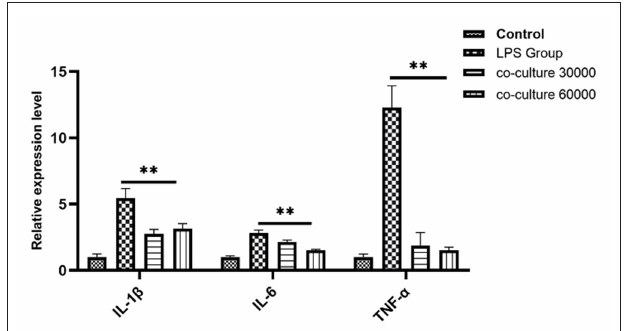
FIGURE 4 | Quantitative PCR analysis for the expression of pro-inflammatory markers such as IL-1 β , IL-6, and TNF- α when co-cultured with bAD-MSC 30,000 cells and 60,000 cells in the presence of 0.1 µ g/mL of LPSs. Expression levels normalized to the reference gene β -actin. Values are mean ± SD ( n = 4). Significance is indicated by ** P <